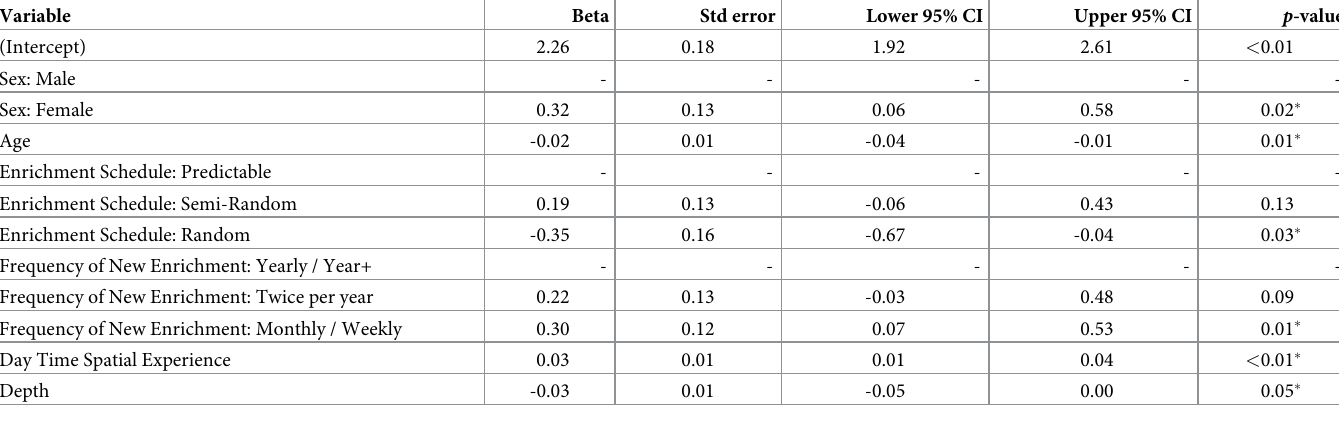
Table 5. Results for the full multivariate model examining